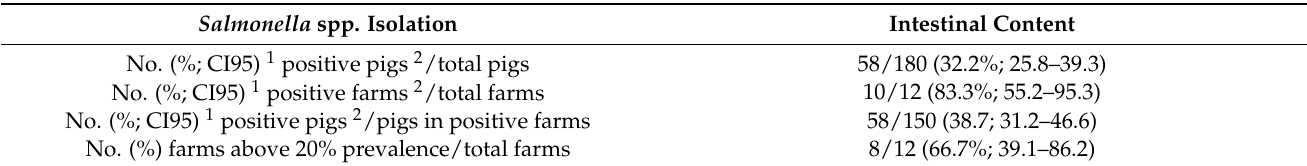
Table 1. Detection of Salmonella by the ISO 6579:2002/Amd 2007 and/or molecular methods in the intestinal content of free-range pigs of North